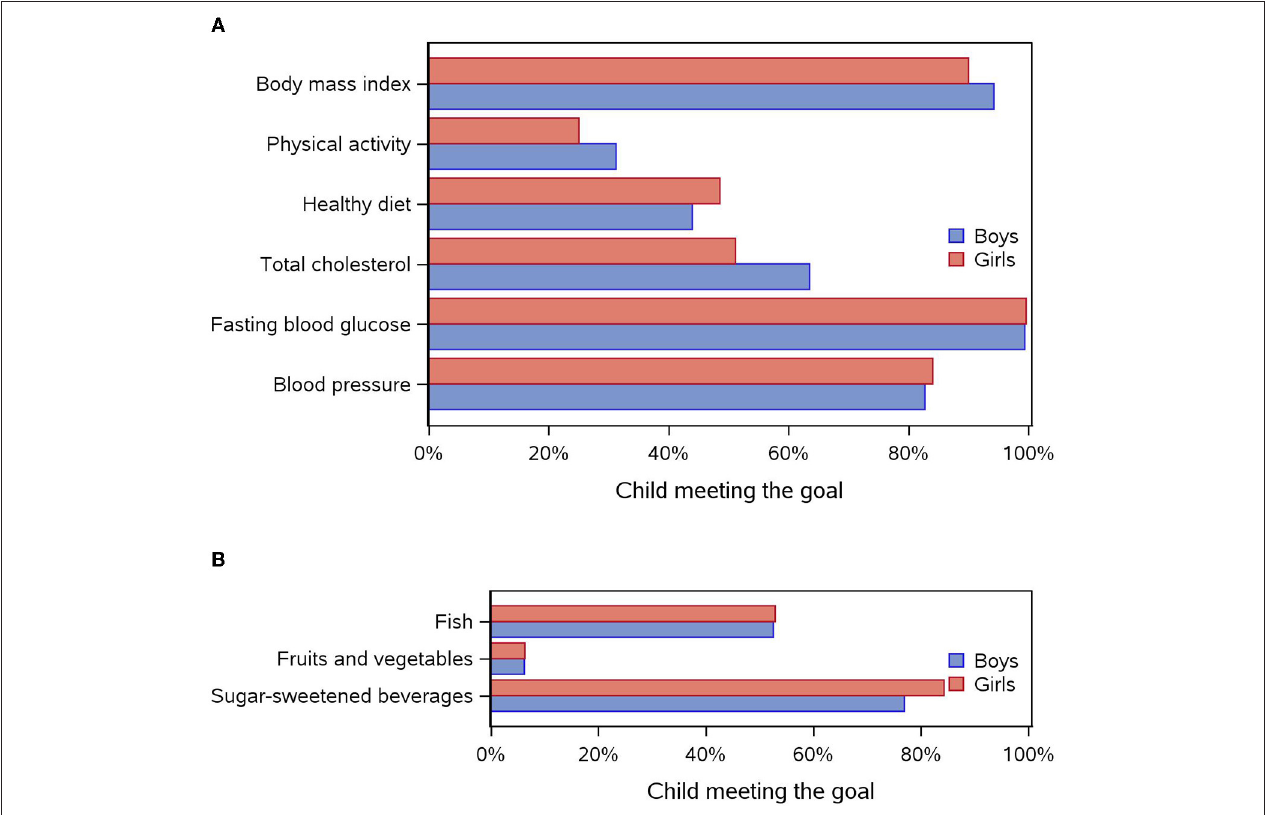
FIGURE 2 | (A) Distribution of each cardiovascular health metric (meeting the goal) according to sex. (B) Distribution of each component of the diet metric (meeting the goal) according to